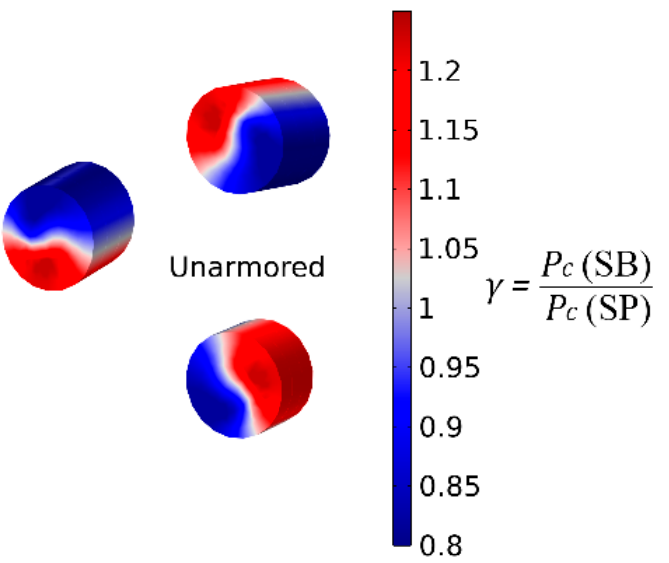
Figure 5. Color plot of the ratio of conductor losses from SP bonding scheme to SB (2000 mm 2 , 275 kV unarmored cable, phase current of 1100 A).